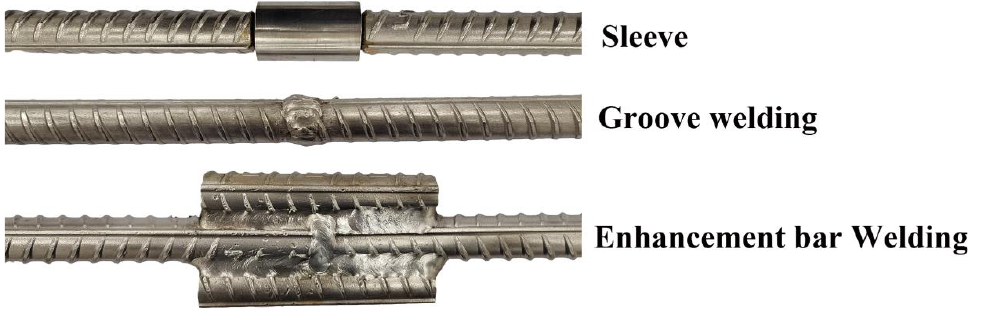
Figure 16. Surface morphology of each joint after rust removal.